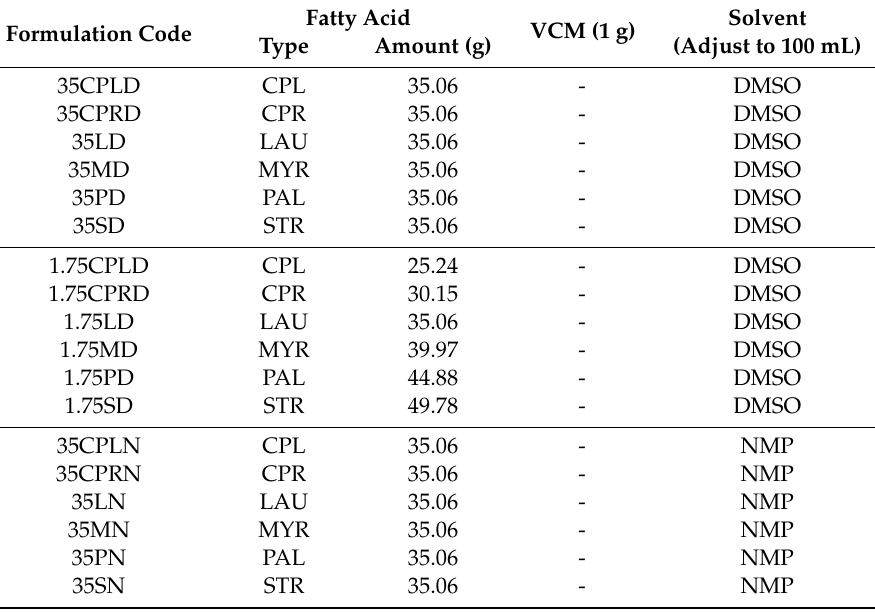
Table 1. Composition of various drug-free in situ forming matrix systems. Formulation